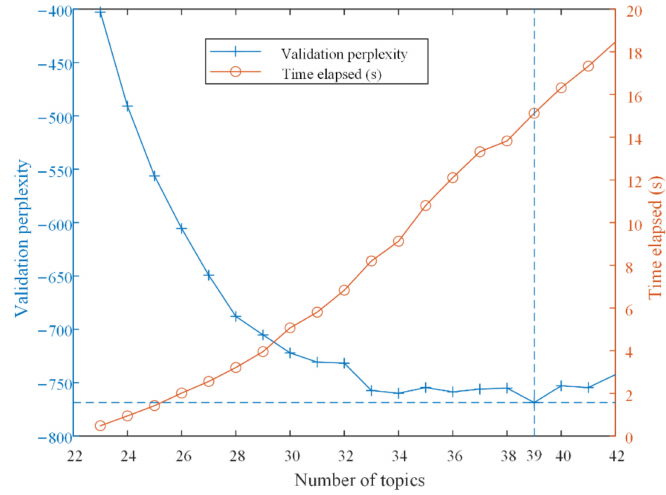
Figure 3. Perplexity-Var values of different topic